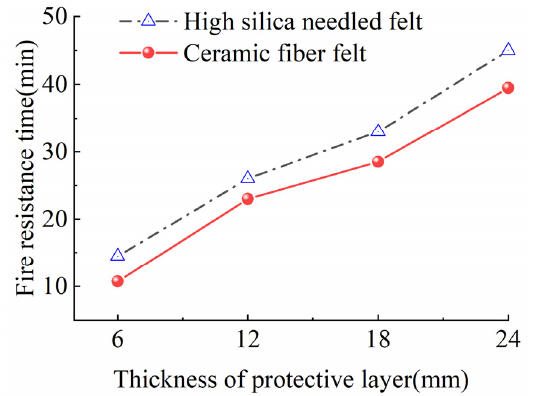
Figure 13. Fire resistance times under different thicknesses of protective layer.